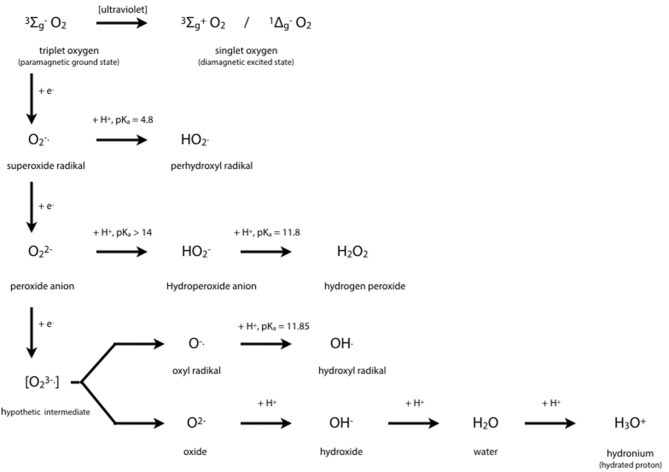
Oxygen Chemistry. Dioxygen itself exists in its ground state as biradical. This is the reason why only the existing partial pressure is healthy to mankind and hyperbaric atmosphere would be toxic. Free radicals derived from successive 1-e− reductions of dioxygen may be harmful to many organic molecules at physiological conditions. Oxygen derivatives are indispensable intermediates in oxidoreductase reactions such as detoxifications, hydroxylations, peroxidations.